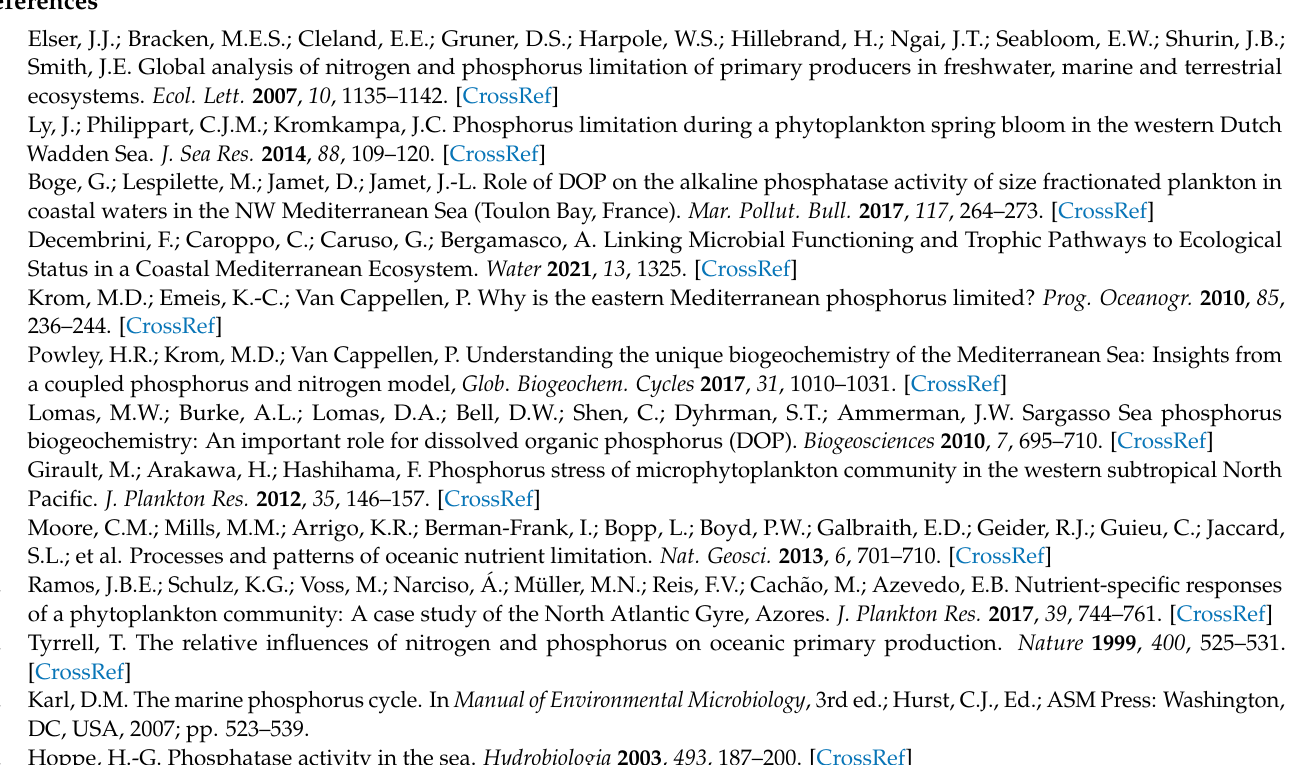
Figure A1. Distribution of ( a ) T, ( b ) S, ( c ) PO 4 , and ( d ) N/P ratio (N/P) in water types in the Northern Adriatic during 2004–2013. Abbreviations and plot characteristics are reported in Figures 3 and 4.